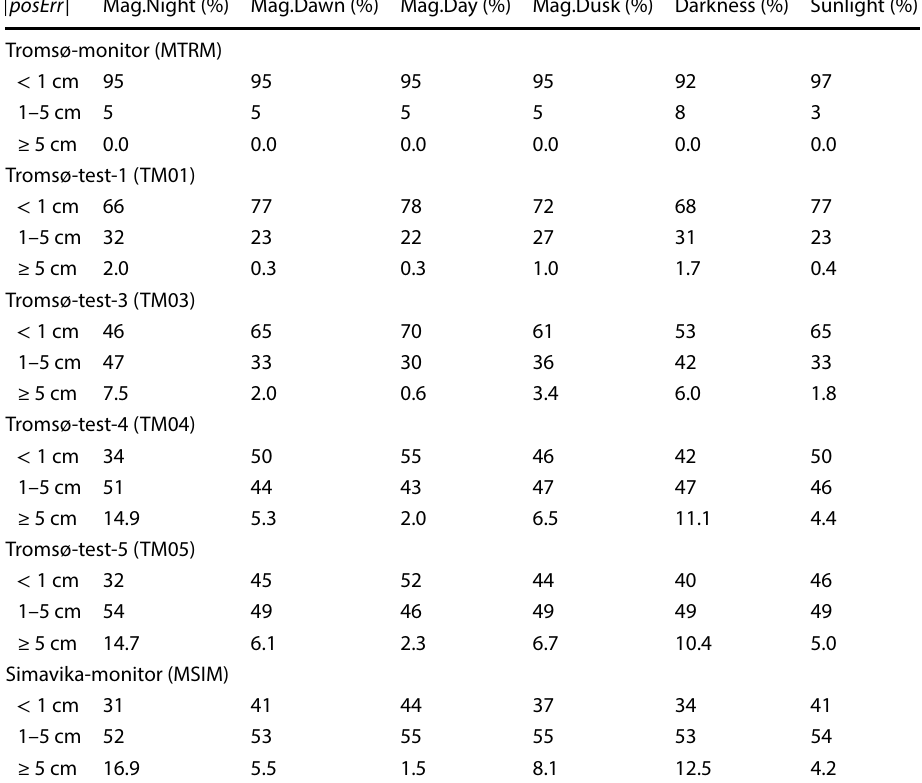
Table 2 Probability for height error